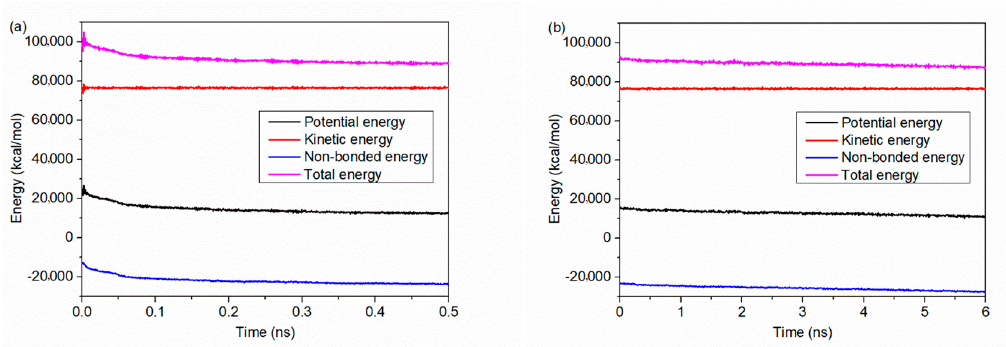
Figure 2. Energy distribution as a function of simulation time during ( a ) the first 0.5 ns and ( b ) the later 6.0 ns. The potential energy, kinetic energy, non-bonded energy and the total energy are calculated, respectively.